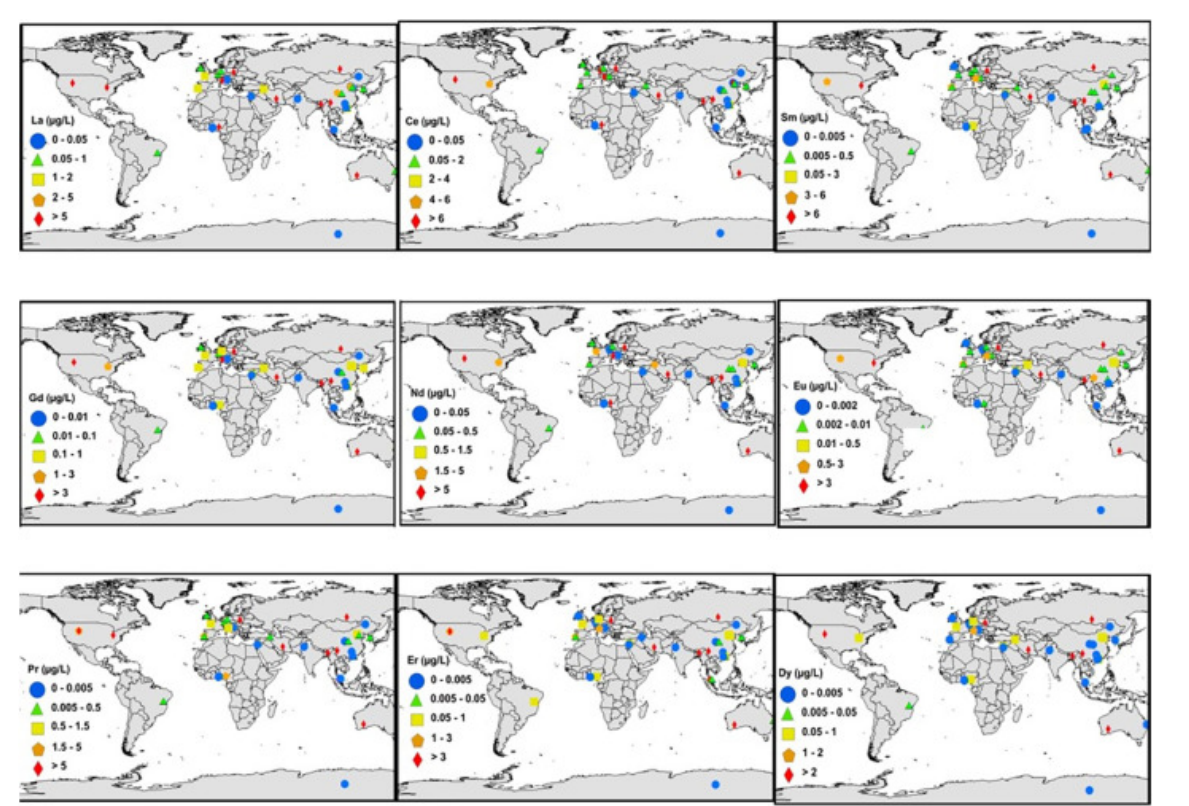
Figure 15. REE levels omitting Pm for many larger waterbodies around the globe [46]. Levels in ocean are much lower (<1 [odd-Z-REEs Tb–Lu] . . . ≈ 50 [La, Ce, Nd] ng/L), similar to blue dots in this diagram